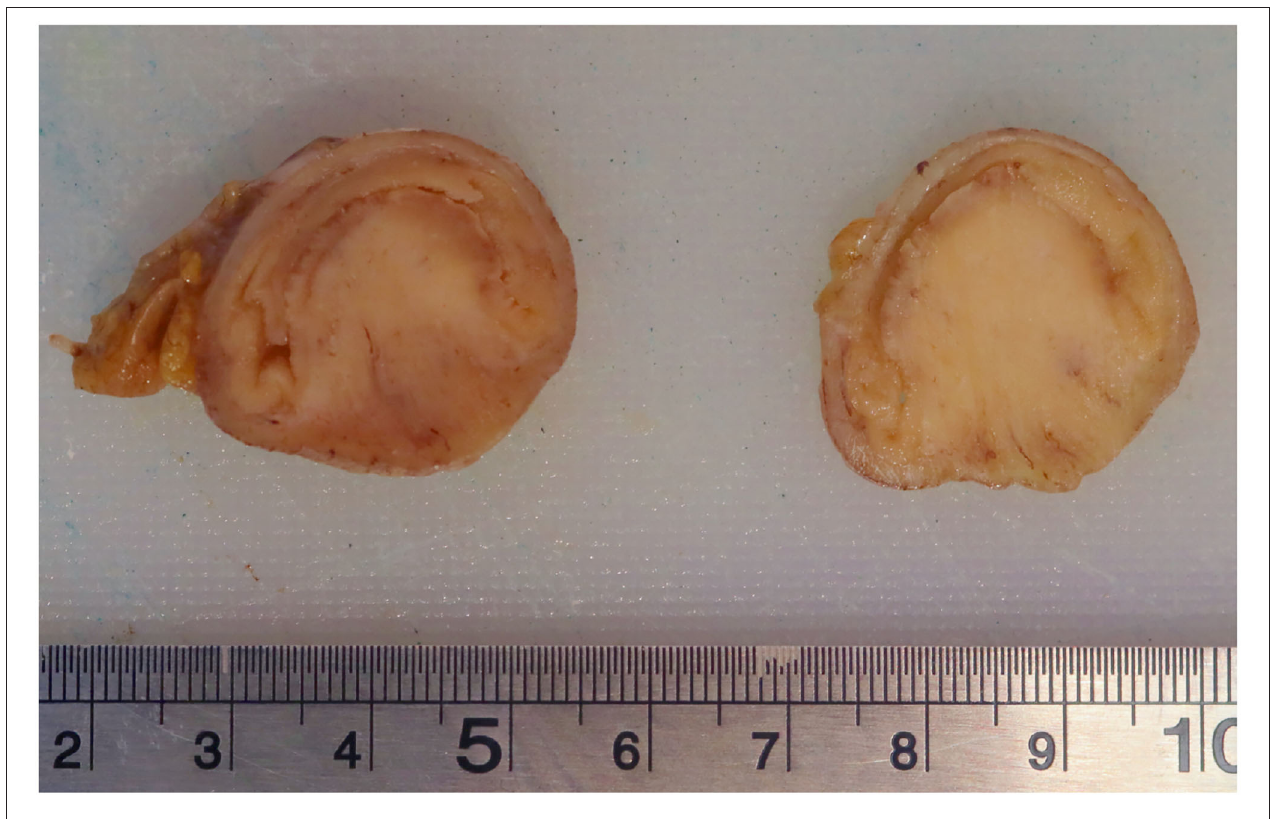
FIGURE 4 | Two cross sections of the ileal tract showing the polypoid lesion.